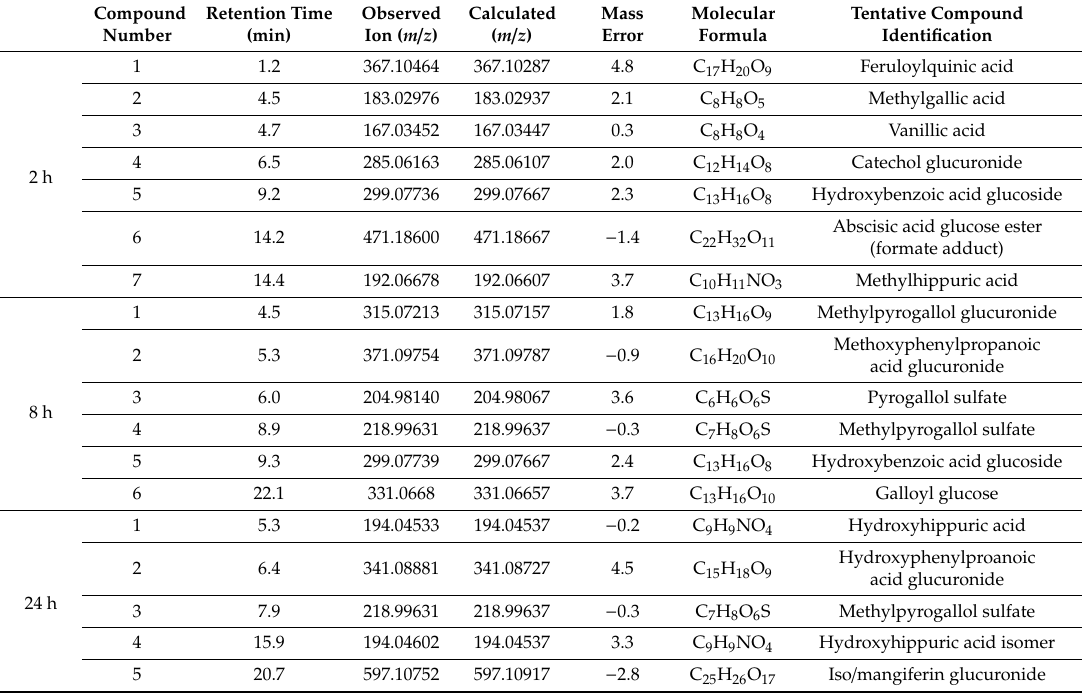
Table 1. (Poly)phenolic metabolites tentatively identified in plasma at di ff erent time points after mango pulp beverage intake (acute